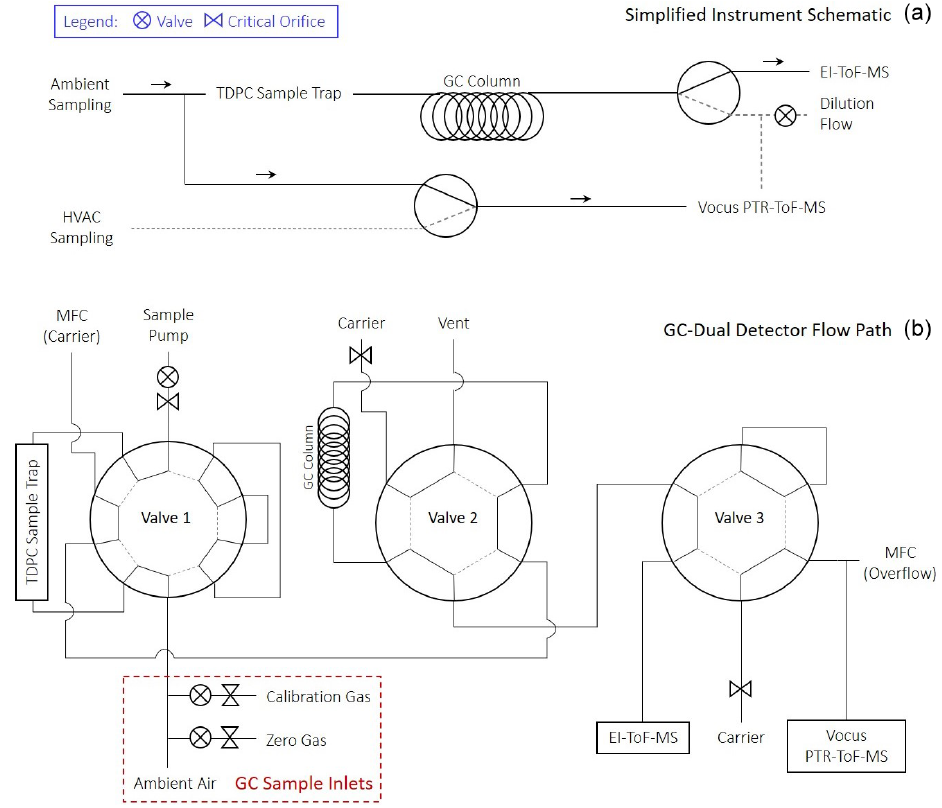
Figure 1. Instrument schematics of (a) dual-detector GC-TOF-MS instrument configuration with valving shown for GC detector selection (EI-TOF or Vocus) and Vocus inlet source (room or supply air or GC effluent). (b) GC flow path and valve positions to incorporate a single-stage thermal desorption preconcentrator (TDPC), single column separation, and dual TOF-MS